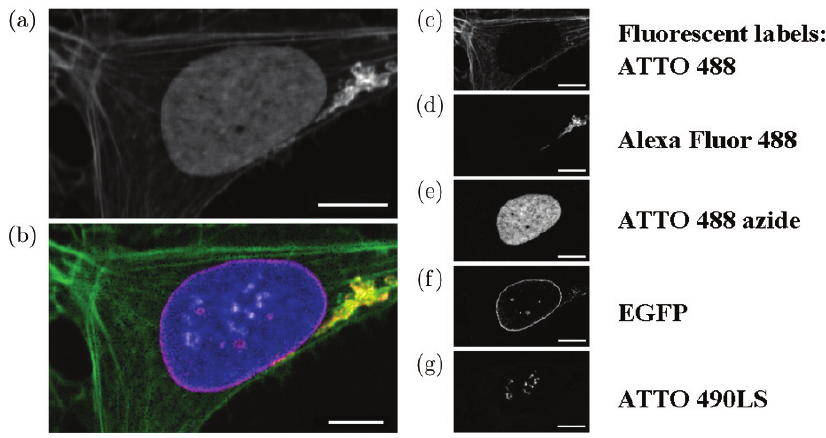
Fig. 1. Multitarget images of di®erent cellular structures labeled with ¯ve °uorescent probes with similar °uorescent properties: (a) Total °uorescence intensity image of an U2OS cell. (b) sFLIM composite image showing (green, c) F -actin, (yellow, d) Golgi, (blue, e) nascent DNA inside the nucleus, (magenta, f) nuclear envelope, and nucleoli (white, g). Scale bars, 10 (cid:2) m.